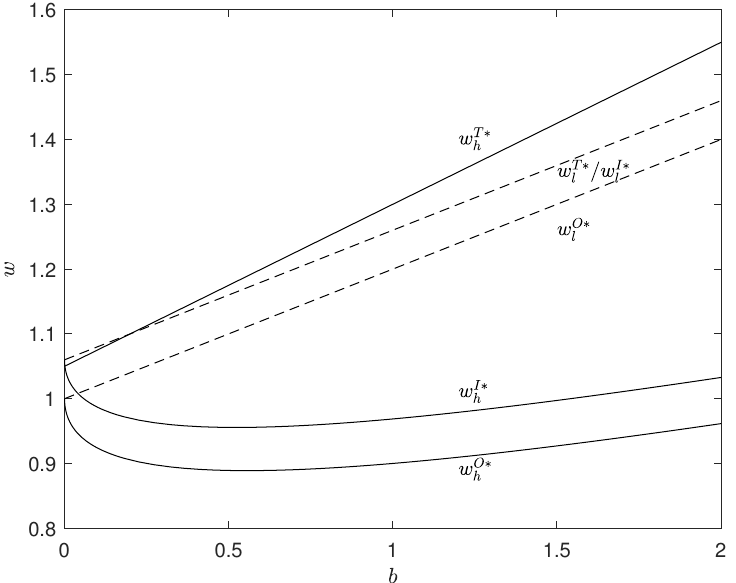
Figure 4. Illustration of Different Impacts of the Consumer Environmental Awareness on Optimal Wholesale Price. The parameters are: t = 1, p c = 0.3, µ = 0.5, G = 0, a = 2, e h = 0.5 and e l =